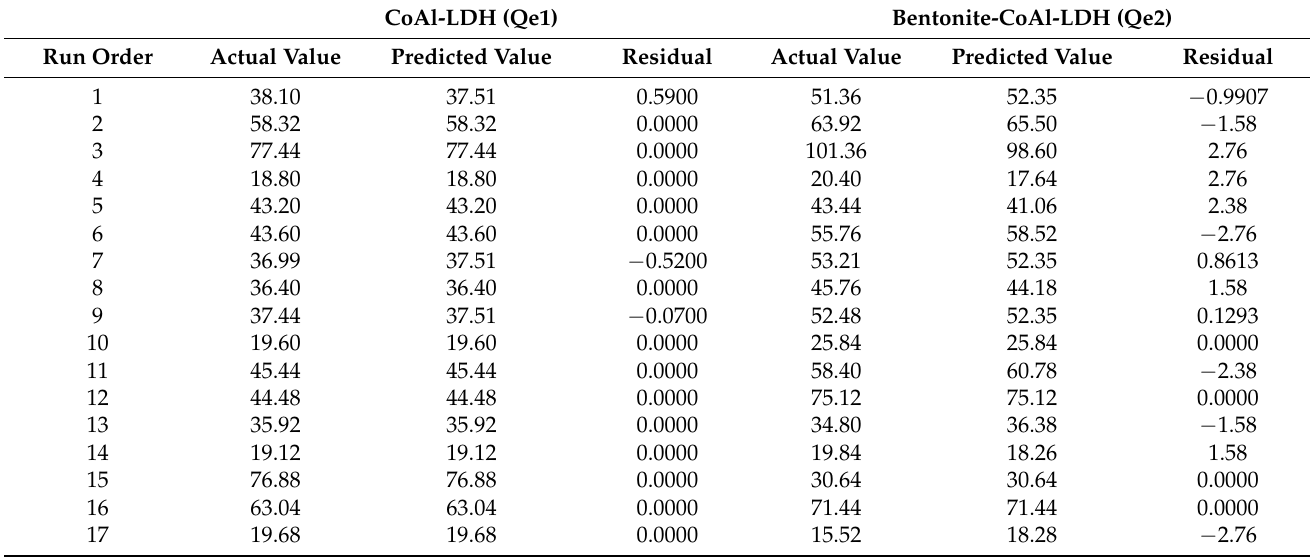
Table 5. RSM models predictions for FC-CCD tests data for Cr(VI) uptake capacity Qe1 and